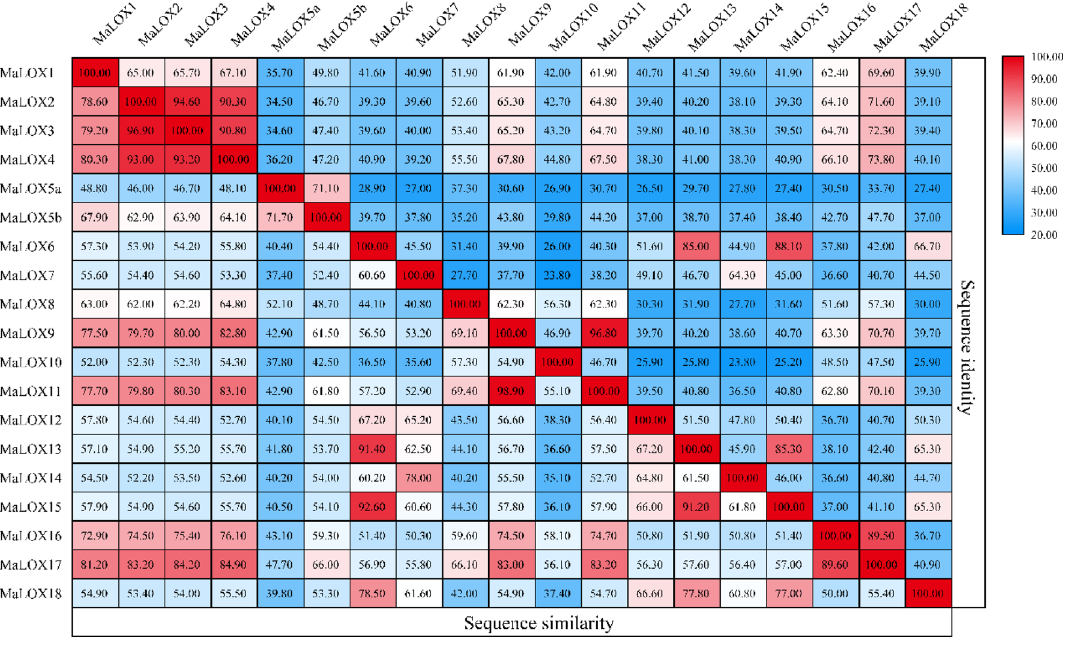
Figure 1. Sequence identities and similarities (%) among the MaLOXs